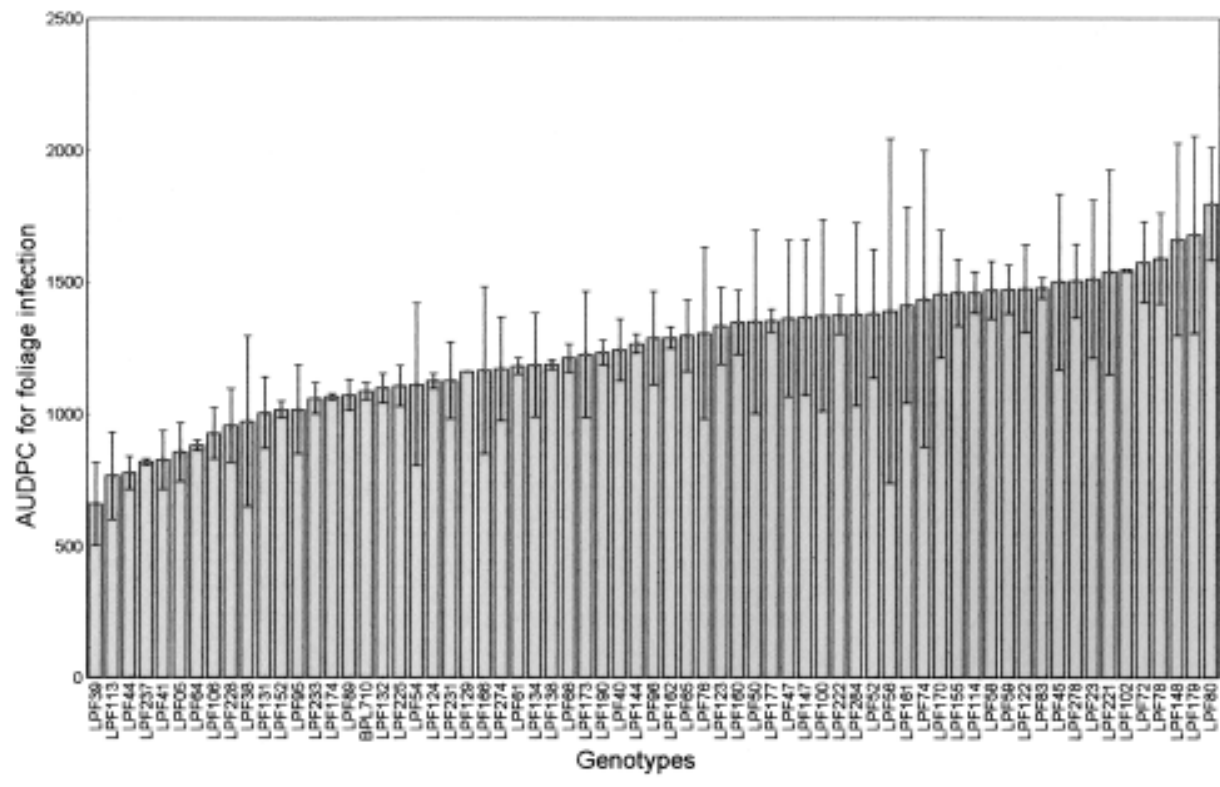
Fig. 1. Classification of 67 genotypes of Vicia faba according to area under disease progress curve (AUDPC) values determined under field conditions. Bars represent standard